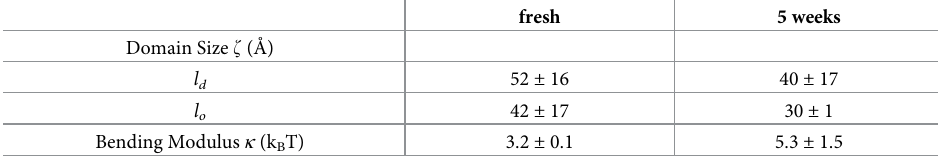
Table 2. Structural parameters and bending modulus κ determined from MD